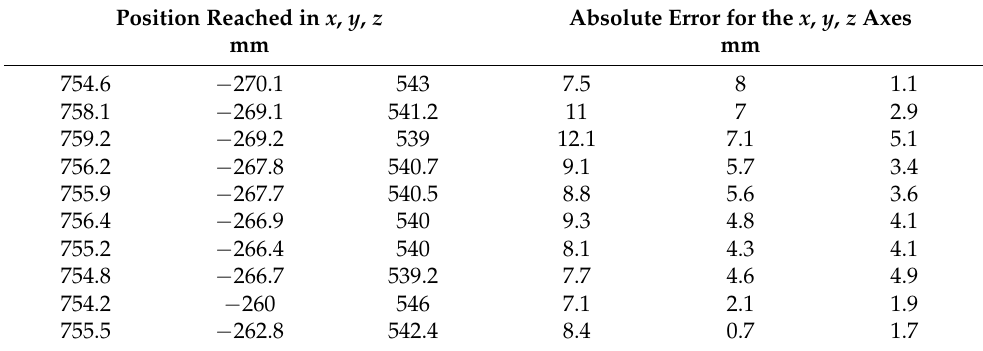
Table 5. Measurement of the position when switching the switch. The reference position is 747.1, − 262.1, 544.1 mm.